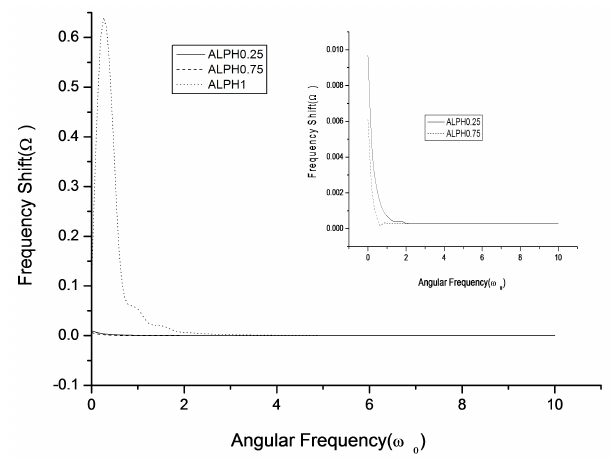
Figure 3: Variation in frequency shift with respect to angular fre-